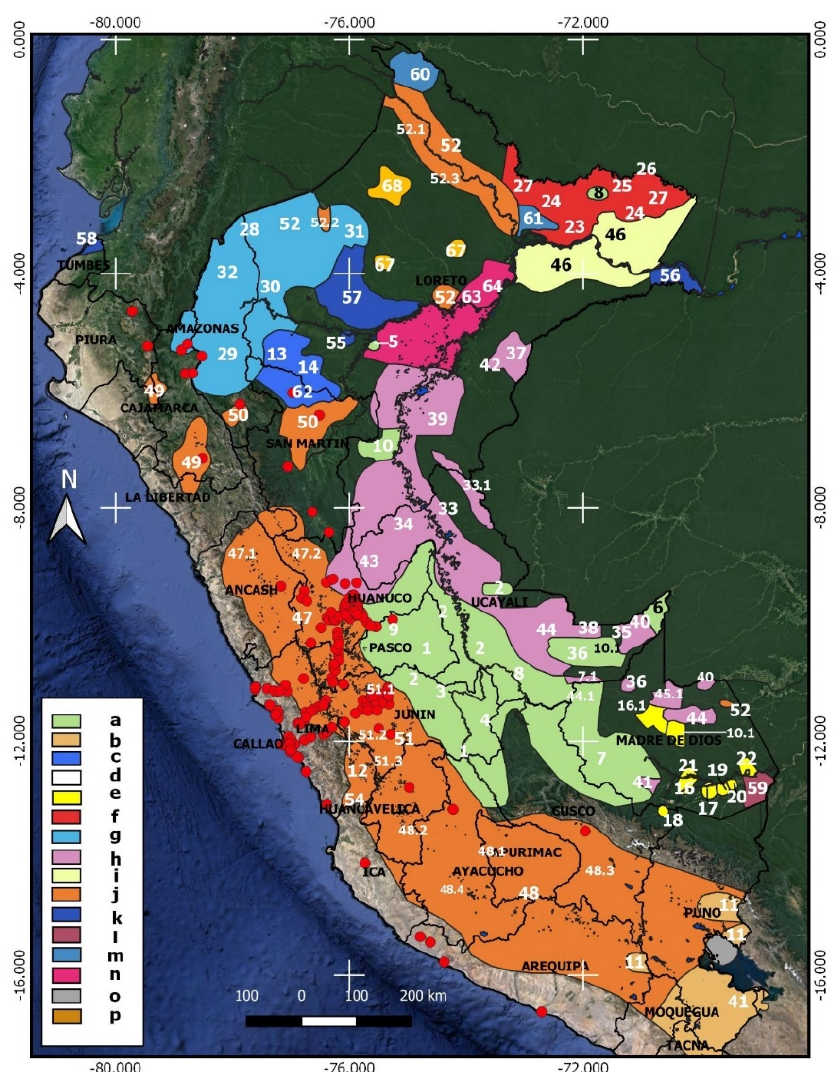
Figure 7. Map showing expedition localities (red dots) and their correspondence with ethnic group families (colored polygons) and ancestral ethnicities (white numbers). Families of ethnic groups: a.